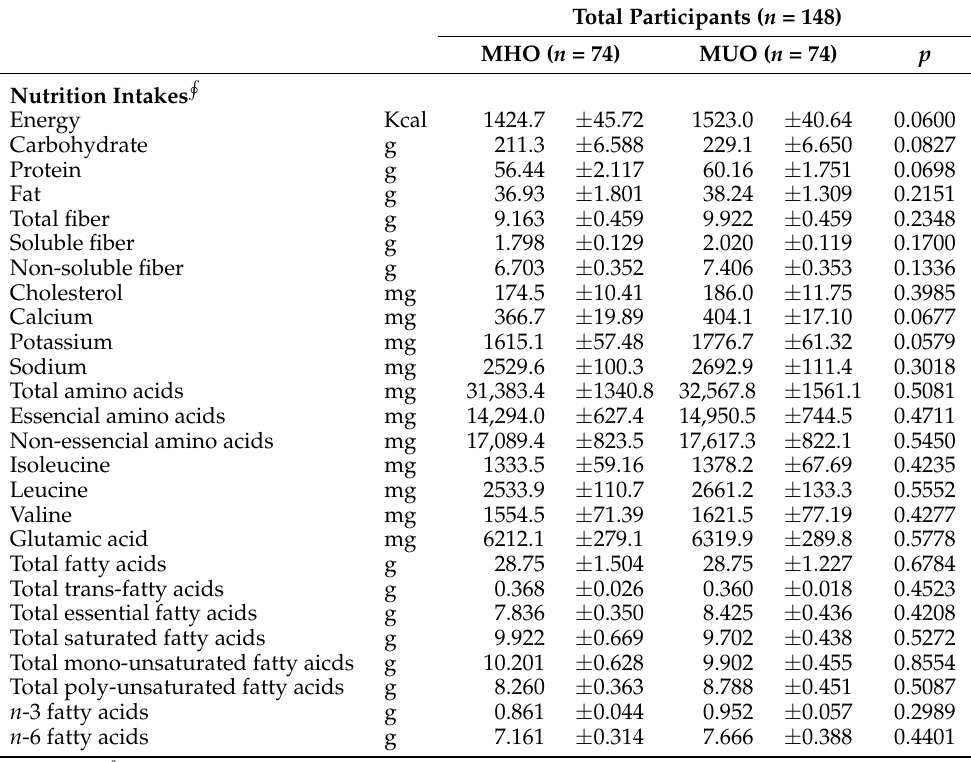
Table 4. The nutrition intakes of adolescents in MUO and MHO groups.